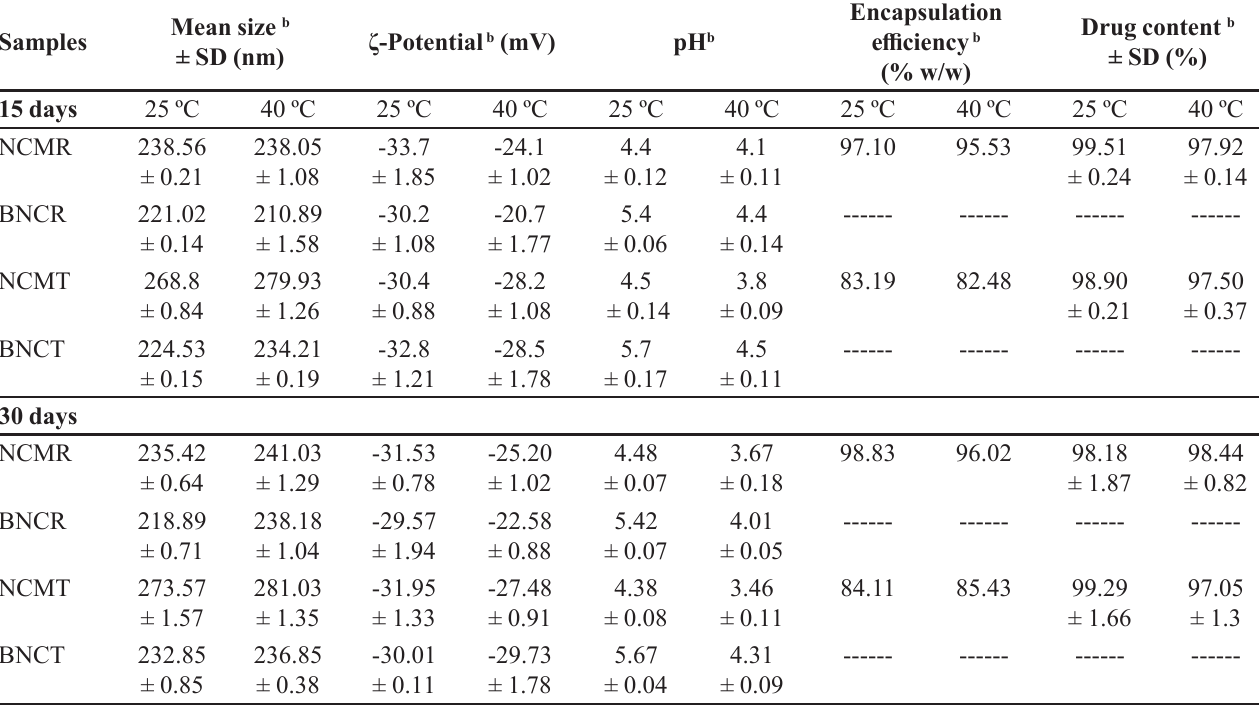
TABLE VII - Physical-chemical characteristics after stability test of polymeric nanocapsules at room temperature and 40 ºC